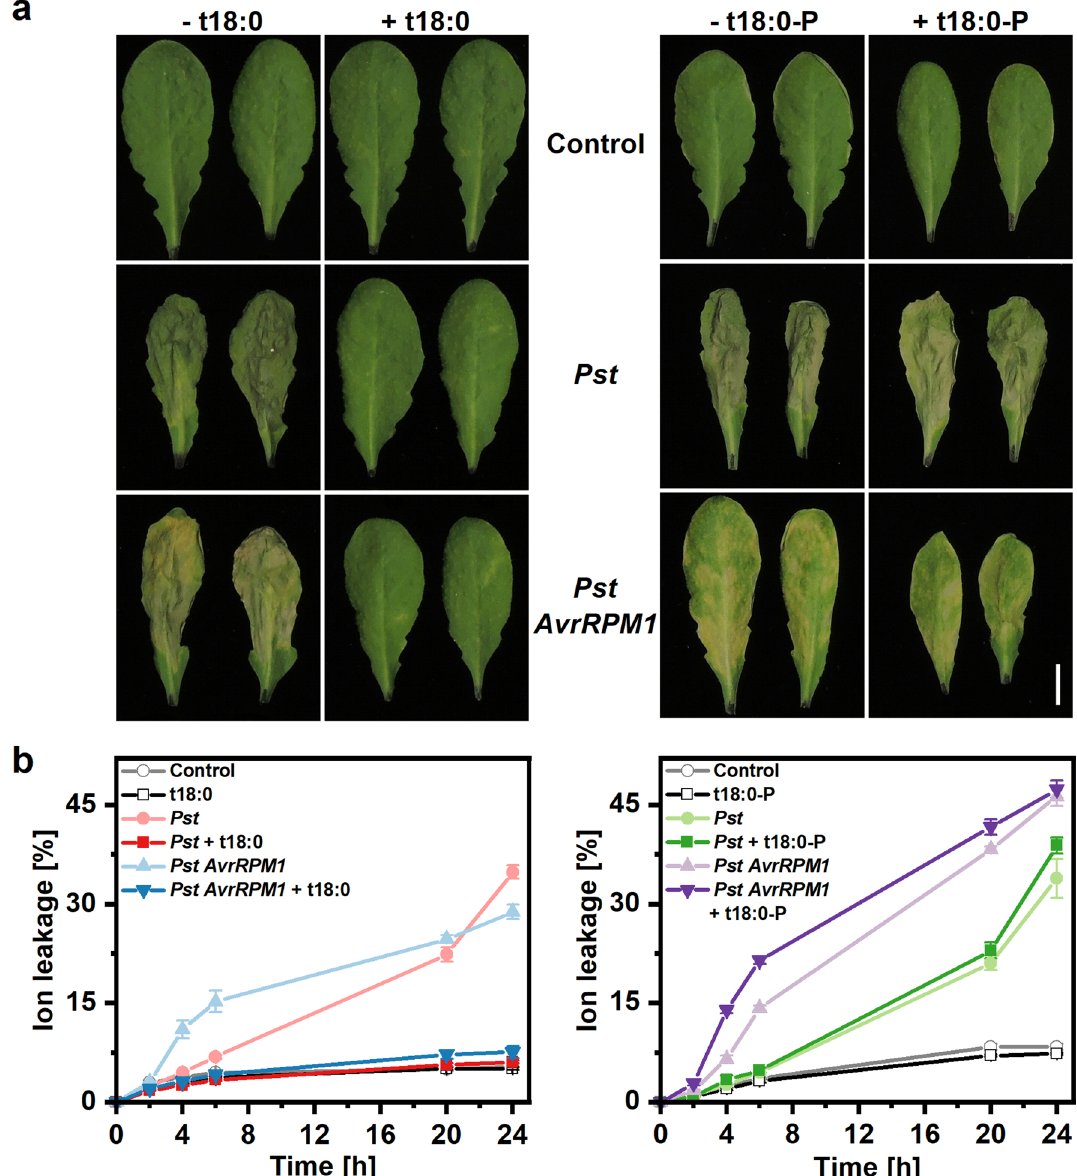
Figure 4. Phytosphingosine co-infiltration with Pseudomonas syringae reduces disease symptoms in Arabidopsis leaves. Two strains of Pseudomonas syringae pv. tomato (Pst) , Pst DC3000 (virulent) and Pst DC3000 AvrRPM1 (avirulent) were diluted to OD 0.01 in either 10 mM MgCl 2 containing 100 µM phytosphingosine (t18:0), 100 µM phytosphingosine-1-phosphate (t18:0-P), or solvent (2% DMSO; Control) only. Leaves were infiltrated and photographs were taken 72 h after infiltration ( a ) to assess leaf damage. Scale bar represents 1 cm. To quantify the development of host cell death ( b ), infiltrated leaves were subjected to leaf disc ion leakage assays. Leaf discs were floated on ultrapure H 2 O and conductivity of the solution was determined for 24 h. Cell death was measured as the conductivity of the solution at respective time points relative to the conductivity of the boiled sample at the end of the experiment, which was set to 100%. The time points indicated represent the time after immersion of leaf discs in ultrapure water. Values are means of three independent samples, each consisting of five leaf discs with error bars indicating standard error of the mean